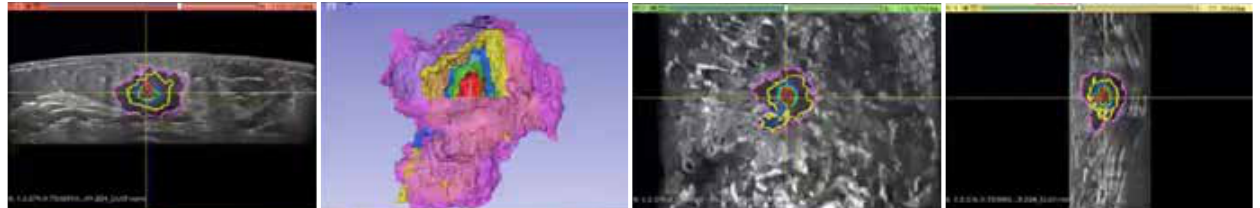
Figure 4 Accurate calculation of breast lesion morphology and volume using ABVS combined with